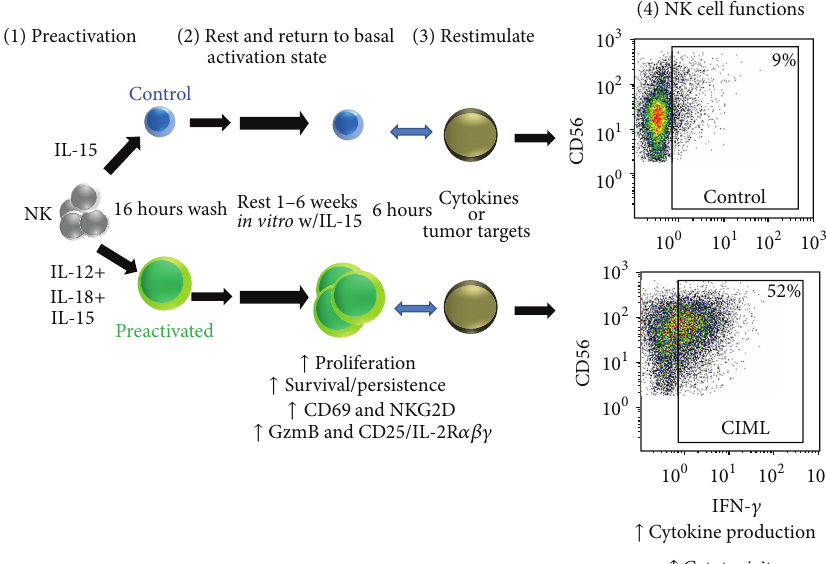
Figure 2: Overview of human cytokine-induced memory-like NK cells. Human NK cells preactivated with IL-12+IL-15+IL-18 for 16 hours return to a basal activation status. Weeks later CIML NK cells have evidence of proliferation and increased expression of CD69, NKG2D, granzyme B, and CD25, compared to control IL-15 preactivated NK cells. When CIML NK cells are restimulated, they exhibit enhanced functional responses, including cytokine production and cytotoxicity against leukemia targets. Similar results are observed when preactivated mice and evaluated 7 days later for in vivo or control human NK cells are adoptively transferred into immunodeficient NOD-SCID- 𝛾 −/− c persistence and enhanced